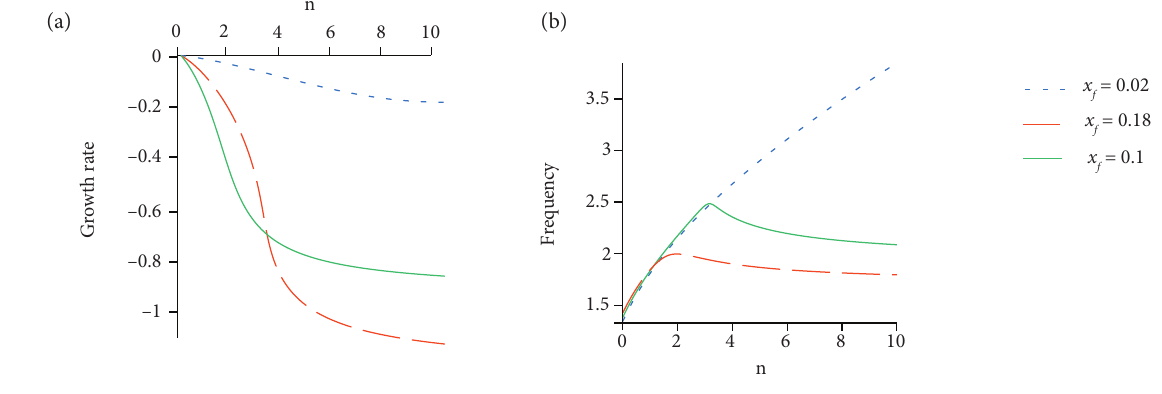
Figure 13. Thermoacoustic characteristics of a ducted resonator: as flame position varies (1L mode, τ = 0.6, x = 0.5, V = 0.2, ω = 2) showing (a) growth rate and (b) h h